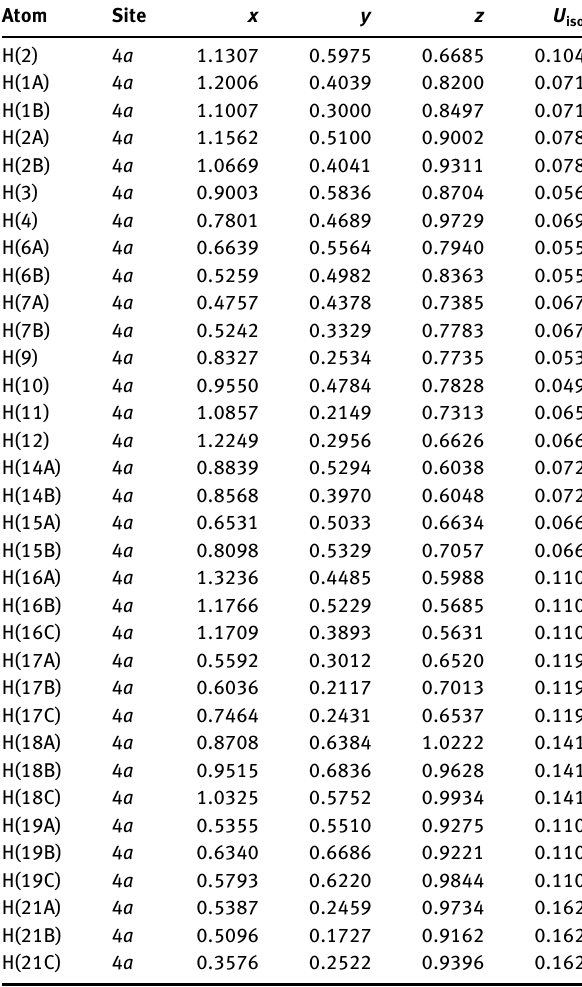
Table 2: Fractional atomic coordinates and isotropic or equivalent isotropic displacement parameters (Å 2